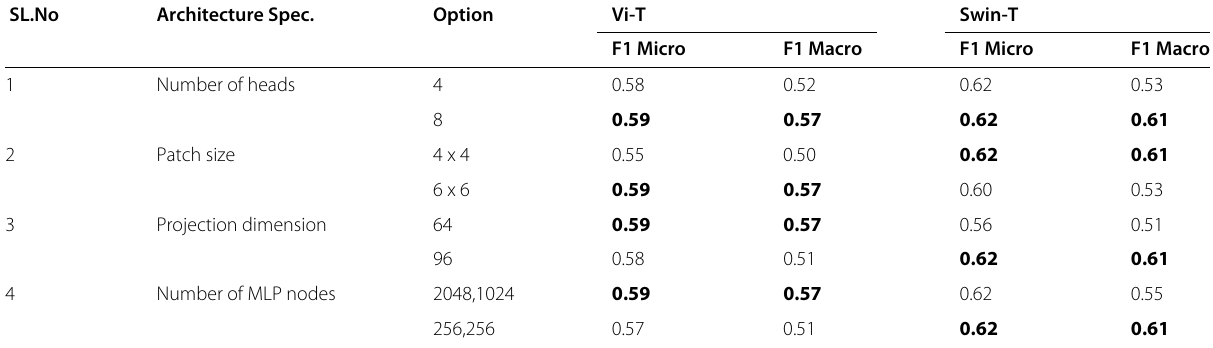
spectrogram analysis are applied to the modgdgram and Table 5 Ablation study of the Mel-spectrogram architecture showing the effect of number of heads, patch size, projection dimension, and number of MLP nodes. Highest values are highlighted SL.No Architecture Spec.